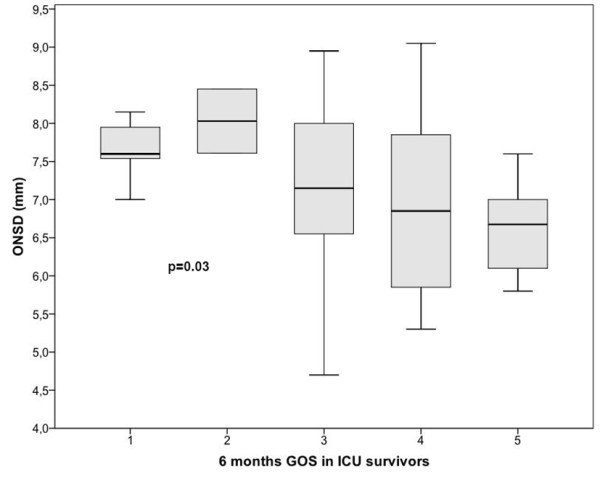
Box plot of optic nerve sheath diameter (mm) according to the Glasgow Outcome Scale (GOS) determined six months after discharge from ICU for 55 survivors (P = 0.03).